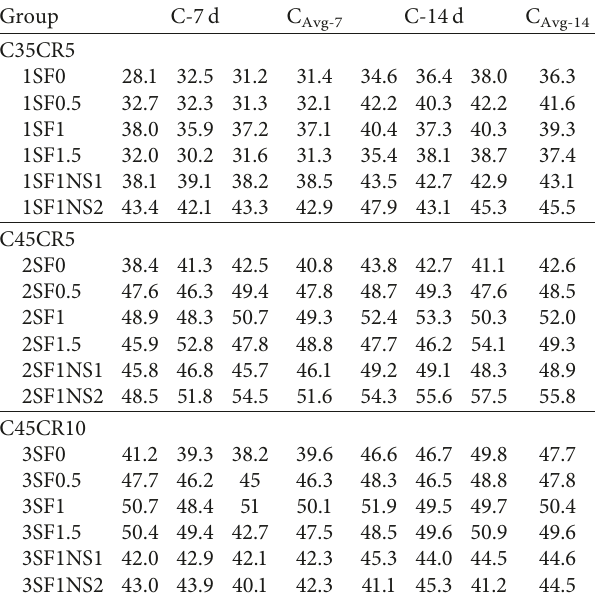
Table 3: Test results of the specimens’ compressive strengths at 7d and 14d (unit: